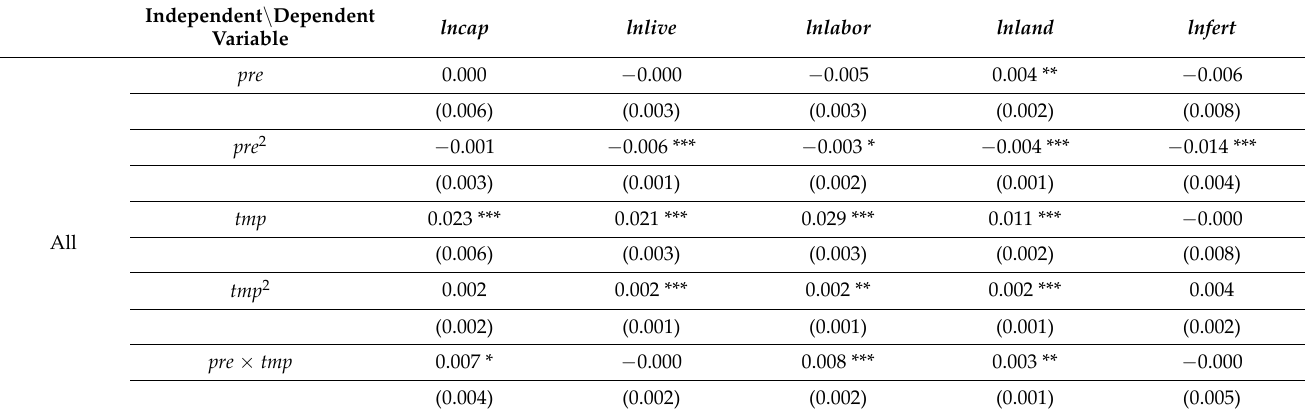
Table A2. Climate change impacts on agricultural inputs across